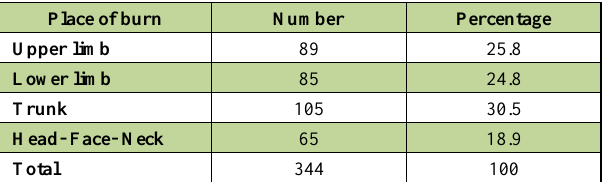
Table2. Frequency Distribution of the place of the burn of Patients Admitted to ICU Burn Center of Rasht City.